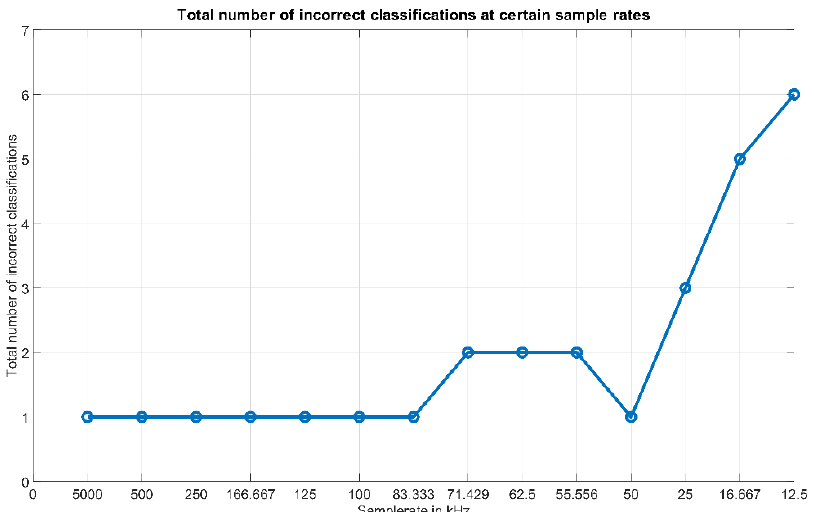
Figure 8. Total number of incorrect classifications at certain sample rates.